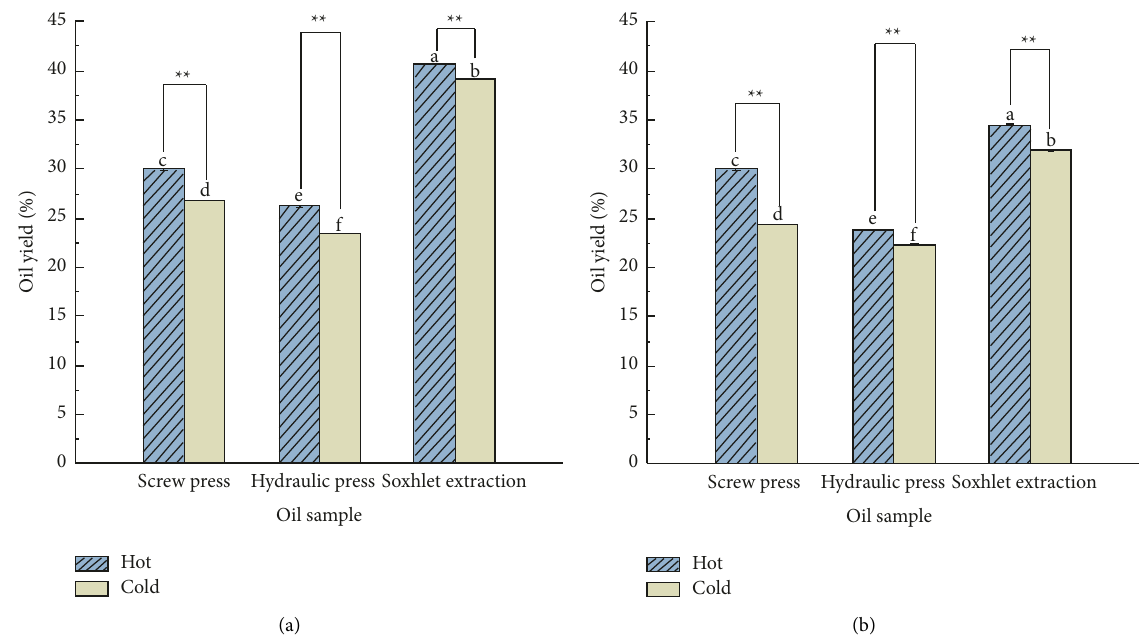
Figure 1: Oil yield of rapeseed and flaxseed oils extracted by different extraction methods. (a) Rapeseed oil and (b) flaxseed oil.